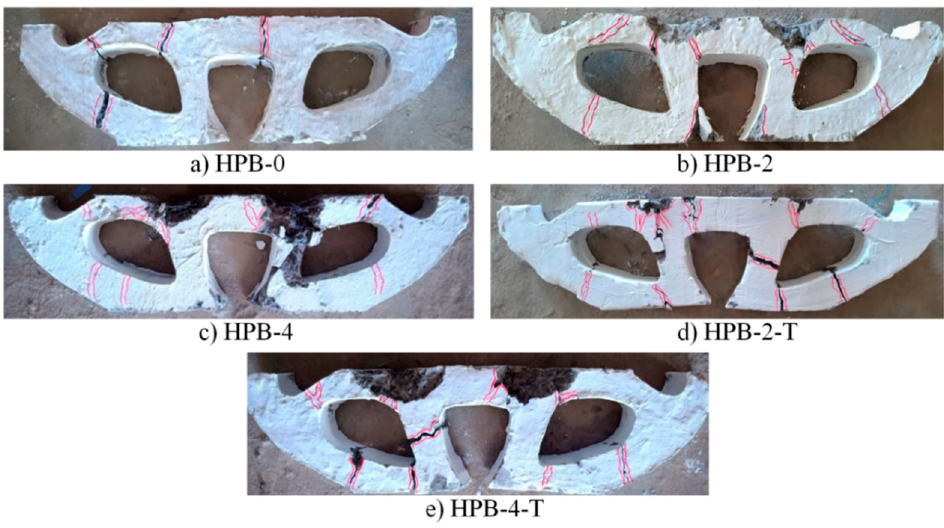
Figure 16. Failure pattern TOHPB ( a ) HPB-0 ( b ) HPB-2 ( c ) HPB-4 ( d ) HPB-2-T and ( e )